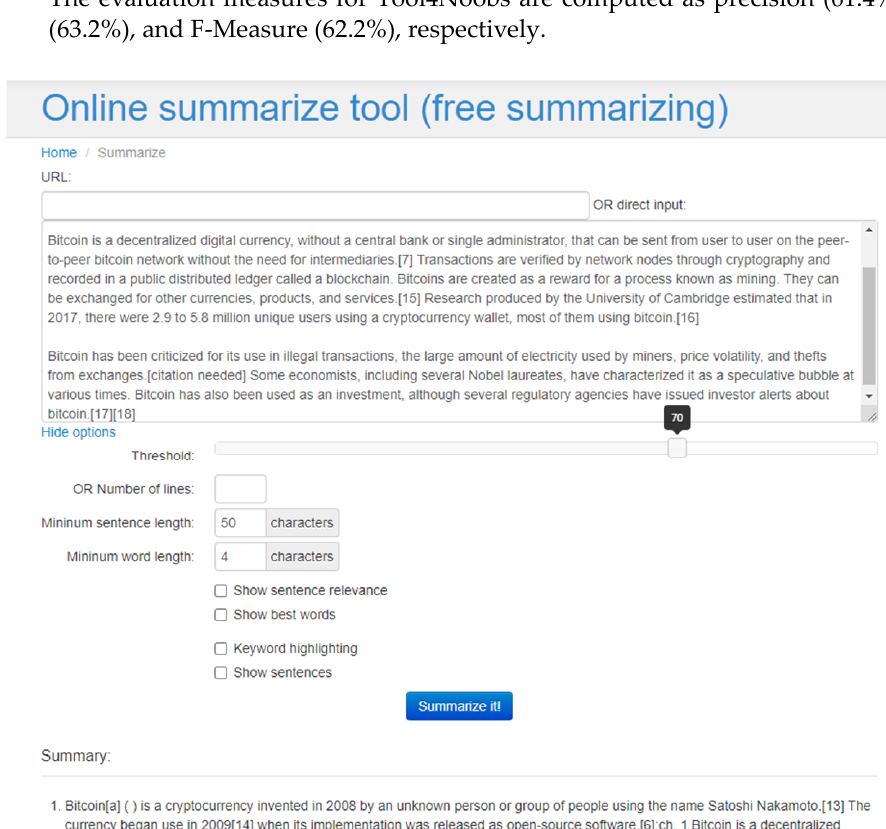
Figure 1. Tool4Noobs summary tool.